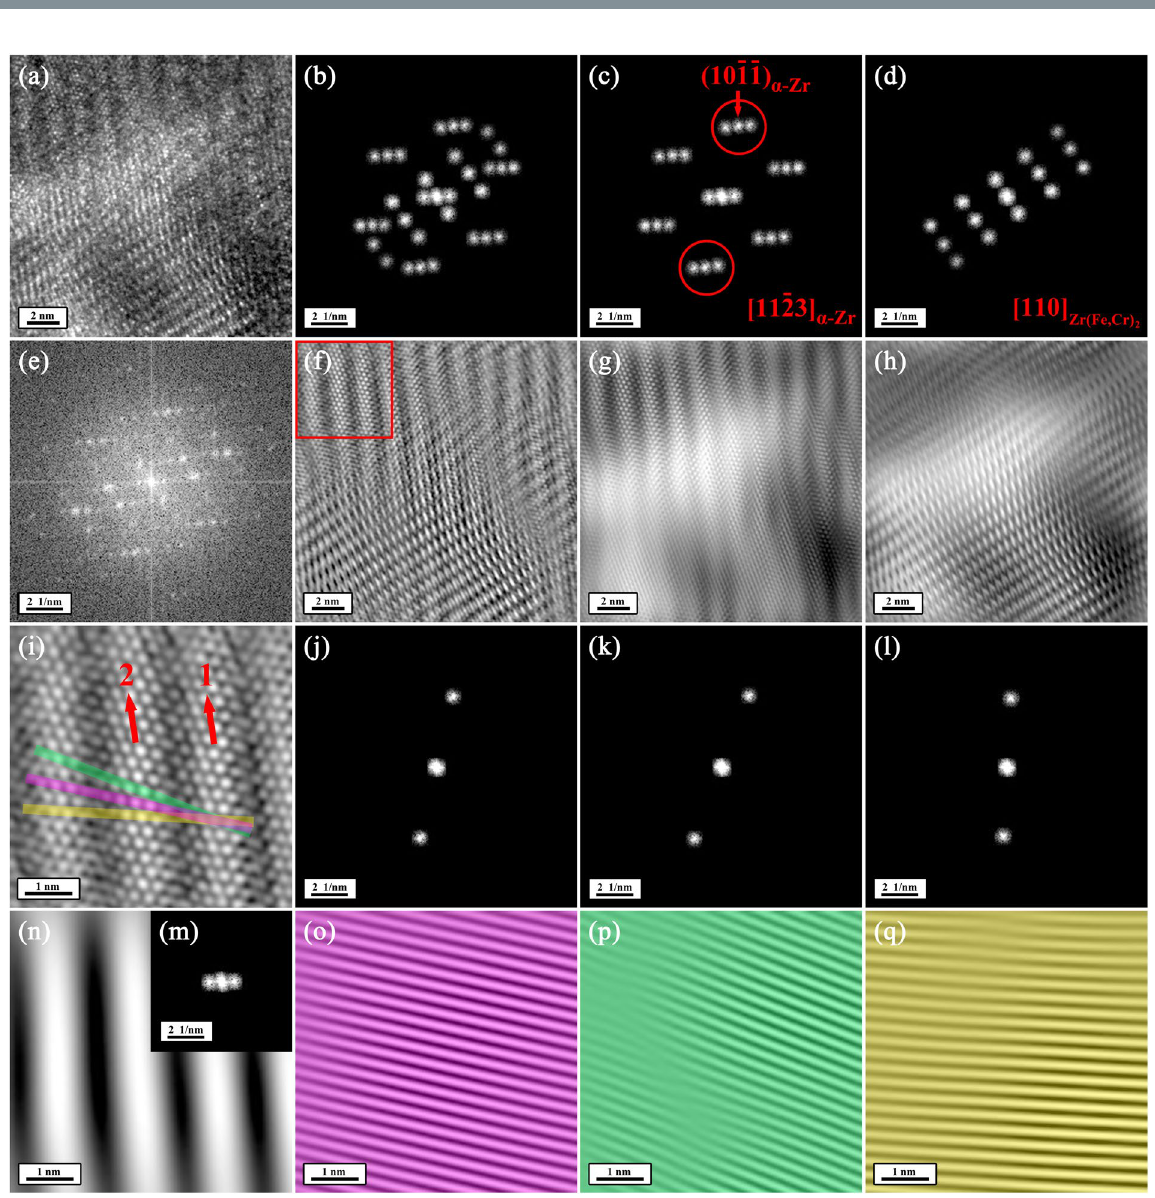
circles in the inserts of Fig. 5h and j), corresponding to new FFT diffraction patterns (Fig. 5c and e). Such an atomic feature can also be seen in Fig. 5k, which is more apparent. In Fig. 5k, moreover, strain fringes can be